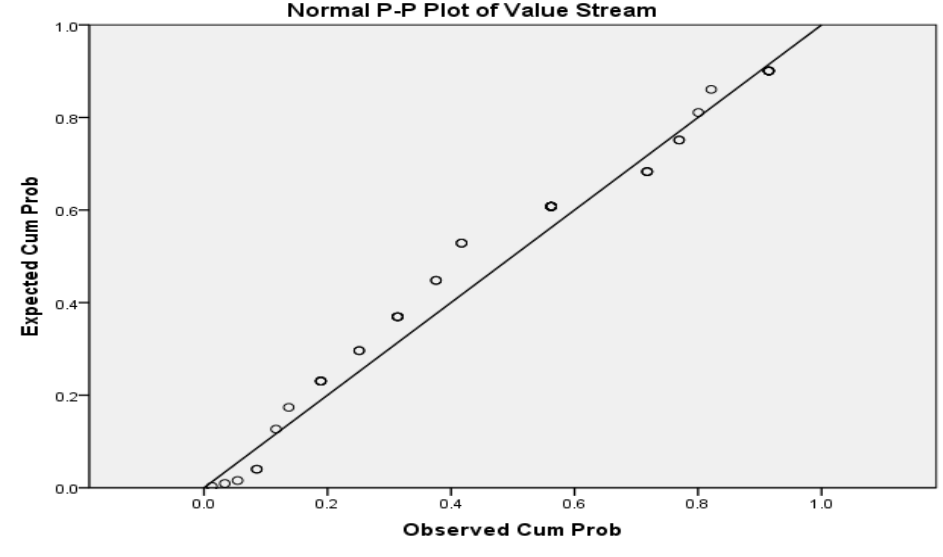
Figure 3. Lean Principles “Value Stream” against ISO 14001